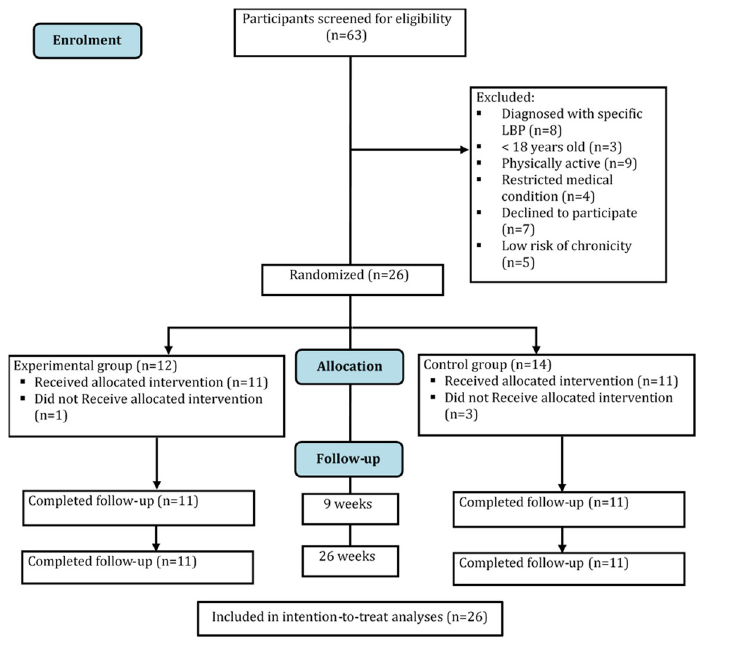
Fig 1. Flow of participants through the